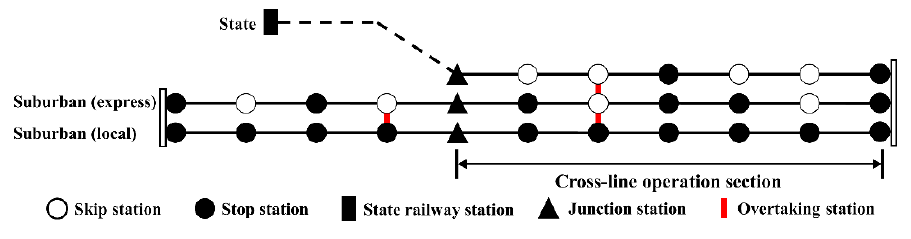
Figure 1. “Y” type cross ‐ line operation between the state railway and suburban railway.